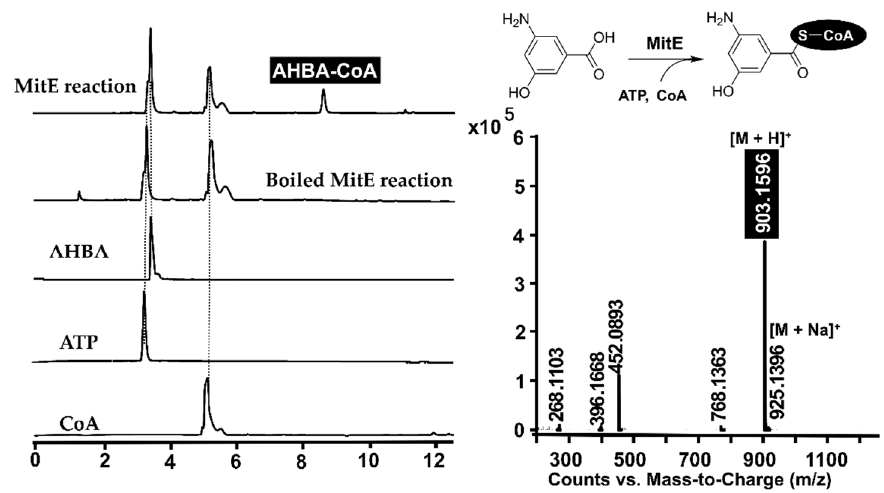
Figure 3. The HPLC-MS analysis of the AHBA-CoA formation.